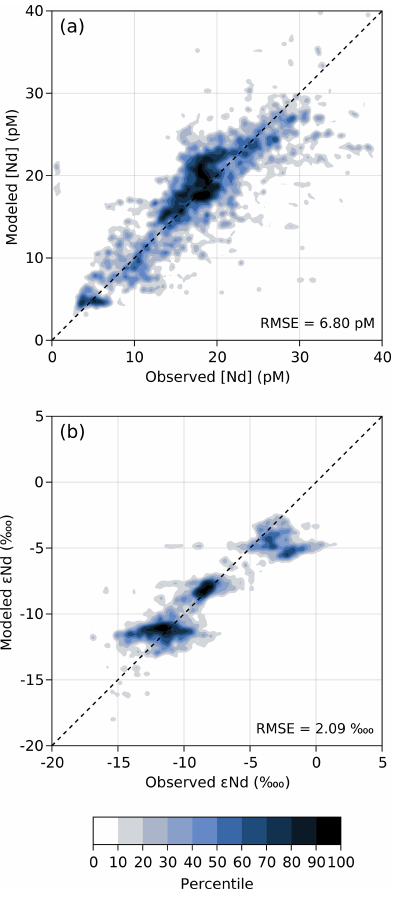
Figure 7. Quantiles of the cumulative joint probability density func- tions of modeled and observed (a) Nd concentrations and (b) ε Nd values. Darker colors indicate a high density of data, such that n % of the modeled and observed data lie outside of the n th percentile contour. The closer the darker contours are to the 1 : 1 black dashed line, the better the